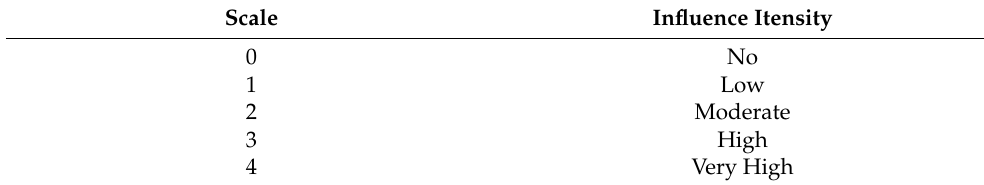
Table 1. Linguistic scale for influential score.